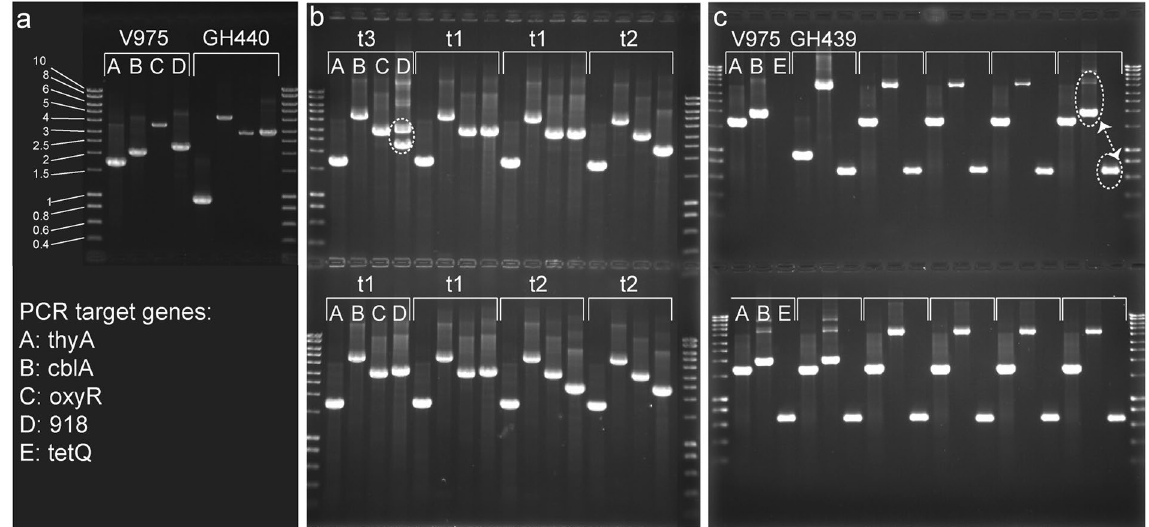
Figure 1. ( a , b ) Amplicon patterns of donor and recipient stains ( a ) and isolates after filter mating experiments ( b ). ( c ) Amplicon patterns of donor and recipient stains and isolates from the murine GI tract. A, B, C, D and E indicate the target (primer pairs) used in PCR, t denominates the different types (1–3) observed. The brackets above indicate tracks that belong to a specific isolate. Patterns indicating potential gene duplication events are circled. The arrow highlights the simultaneous presence of the wt cblA gene and the tetR gene in this isolate.